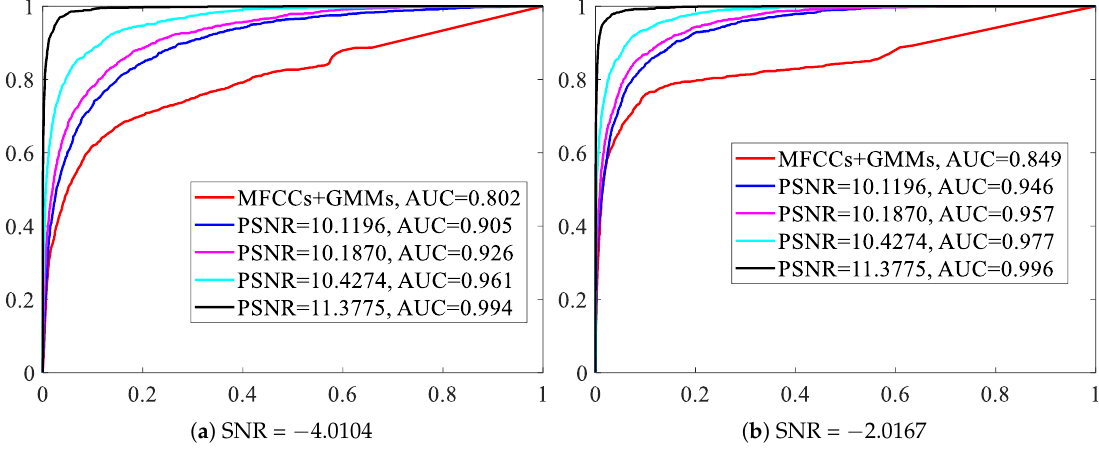
Figure 13. Receiver operating characteristics (ROC) curves of FFS II-Acoustics-Visual and Mel-frequency cepstral coefficients (MFCCs) + Gaussian mixture models